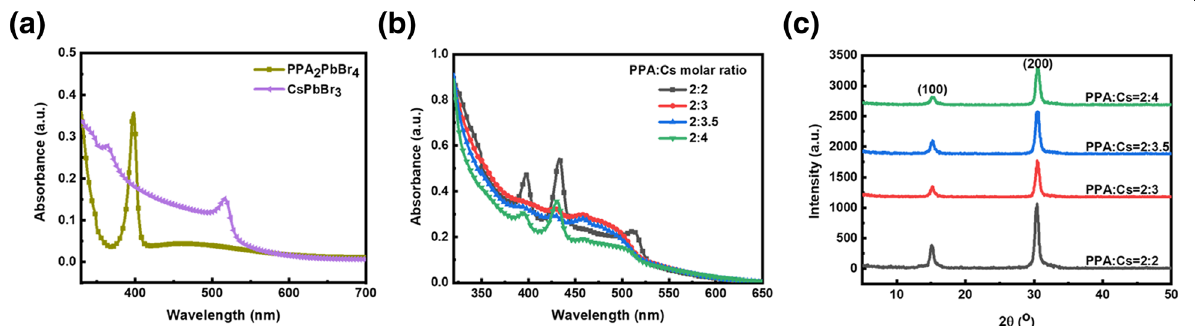
Fig. 1 Absorption spectra in thin films of a the 3D CsPbBr 3 and 2D PPA 2 PbBr 4 perovskite, and b quasi-2D compounds with different molar ratios of PPA:Cs cations of 2:2, 2:3, 2:3.5, and 2:4. c XRD patterns of quasi-2D perovskite films with molar ratio of PPA:Cs cations of 2:2, 2:3, 2:3.5, and 2:4